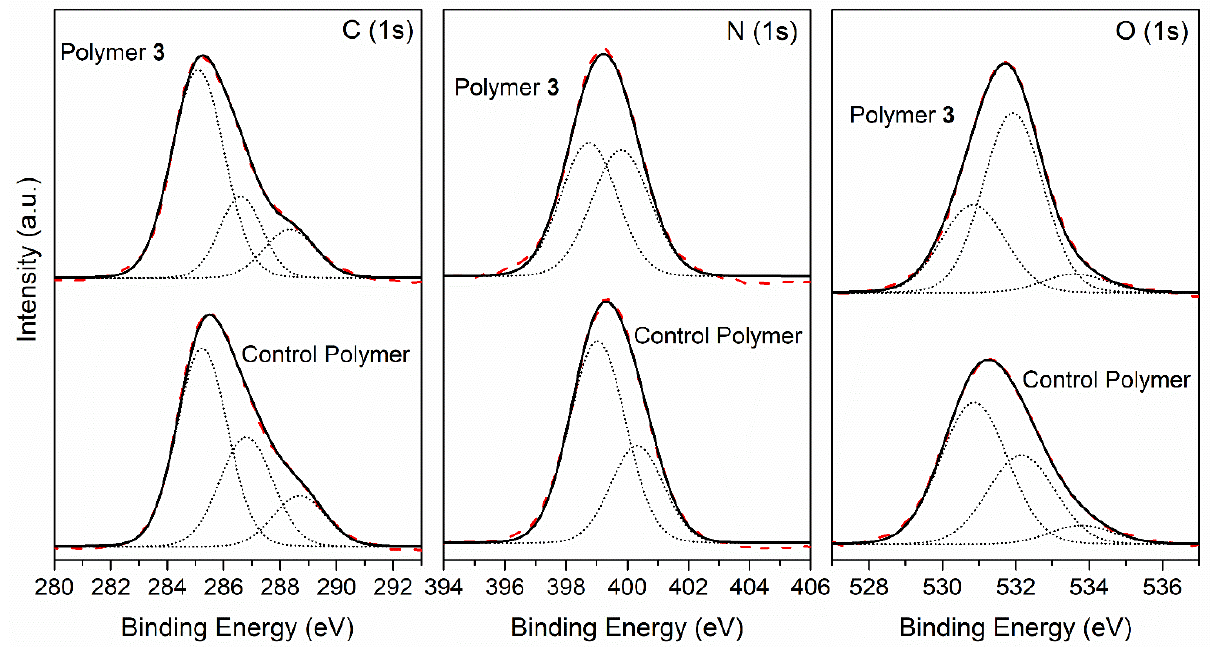
Figure 9. XPS photoemission spectra of the C (1 s), N (1 s) and O (1 s) core level peaks, and the deconvolution of a control polymer and polymer 3 .